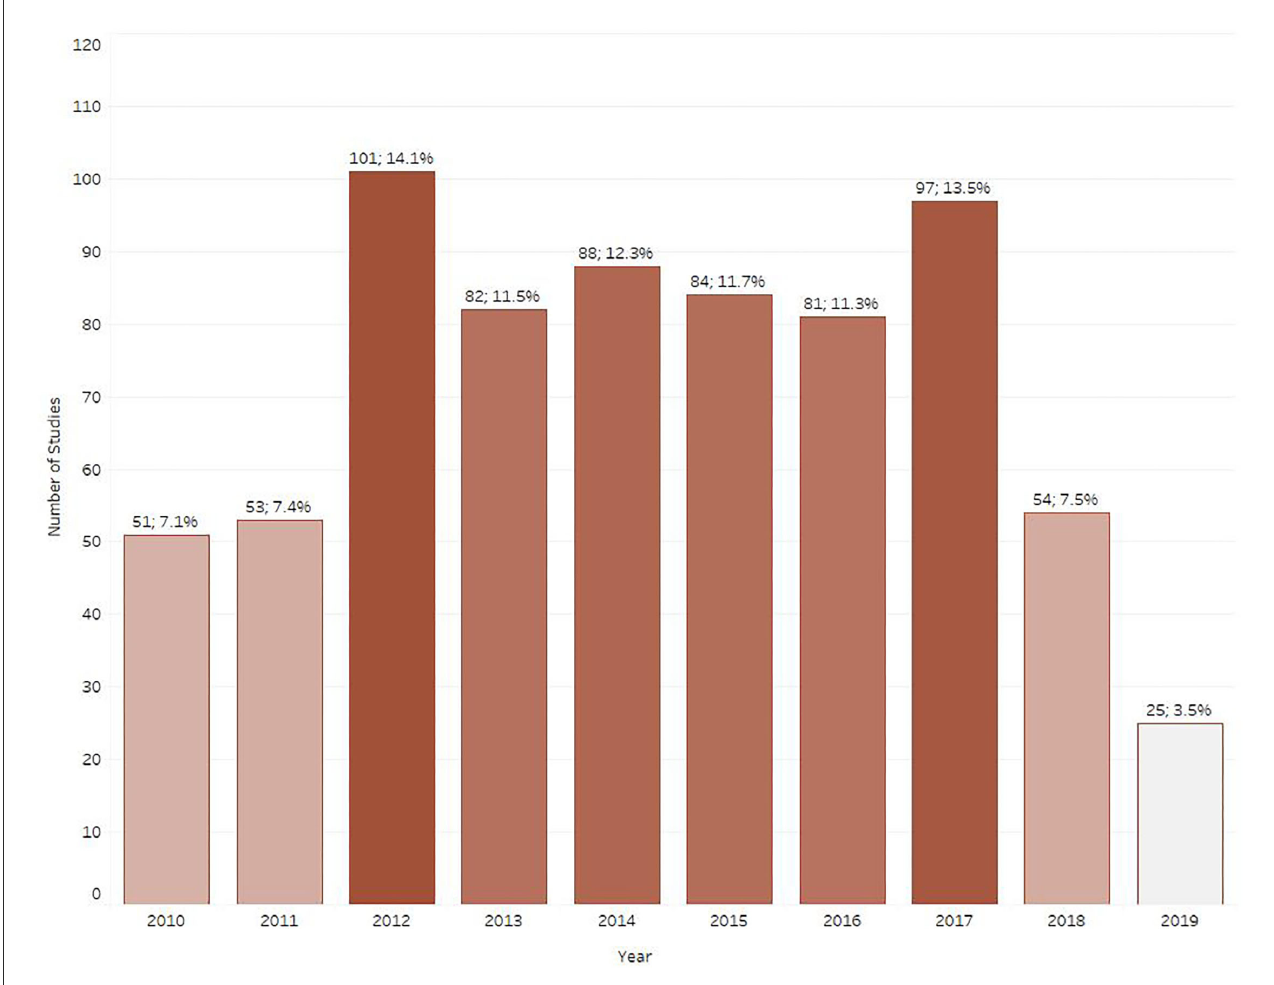
FIGURE4 Number of retrieved studies published each year between 2010 and 2019.